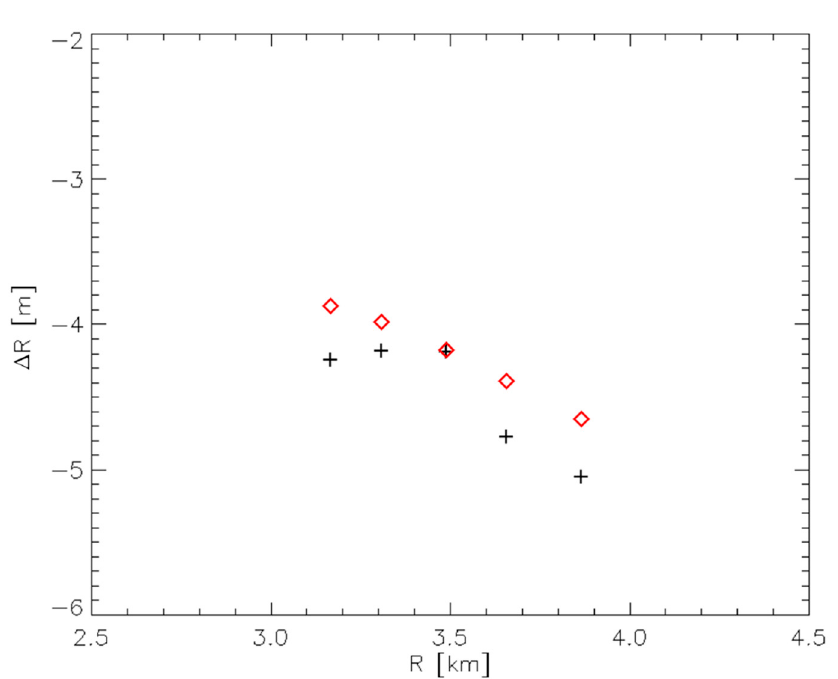
Figure 7. Relevant to Equation (3) and to the 5 CRs considered in the Experiment 1A (black crosses) and Experiment 2A (red diamonds). For each CR it is plotted the difference Δ R in Equation (3) as a function of the CR-to-radar distance R.